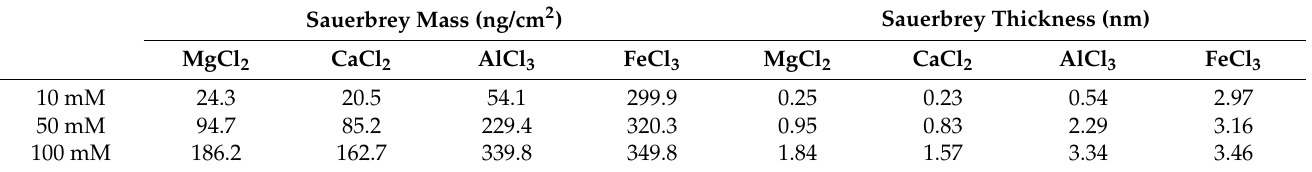
Table 3. Mass adsorption of different coagulants on QCM-D carbon sensors following the linear